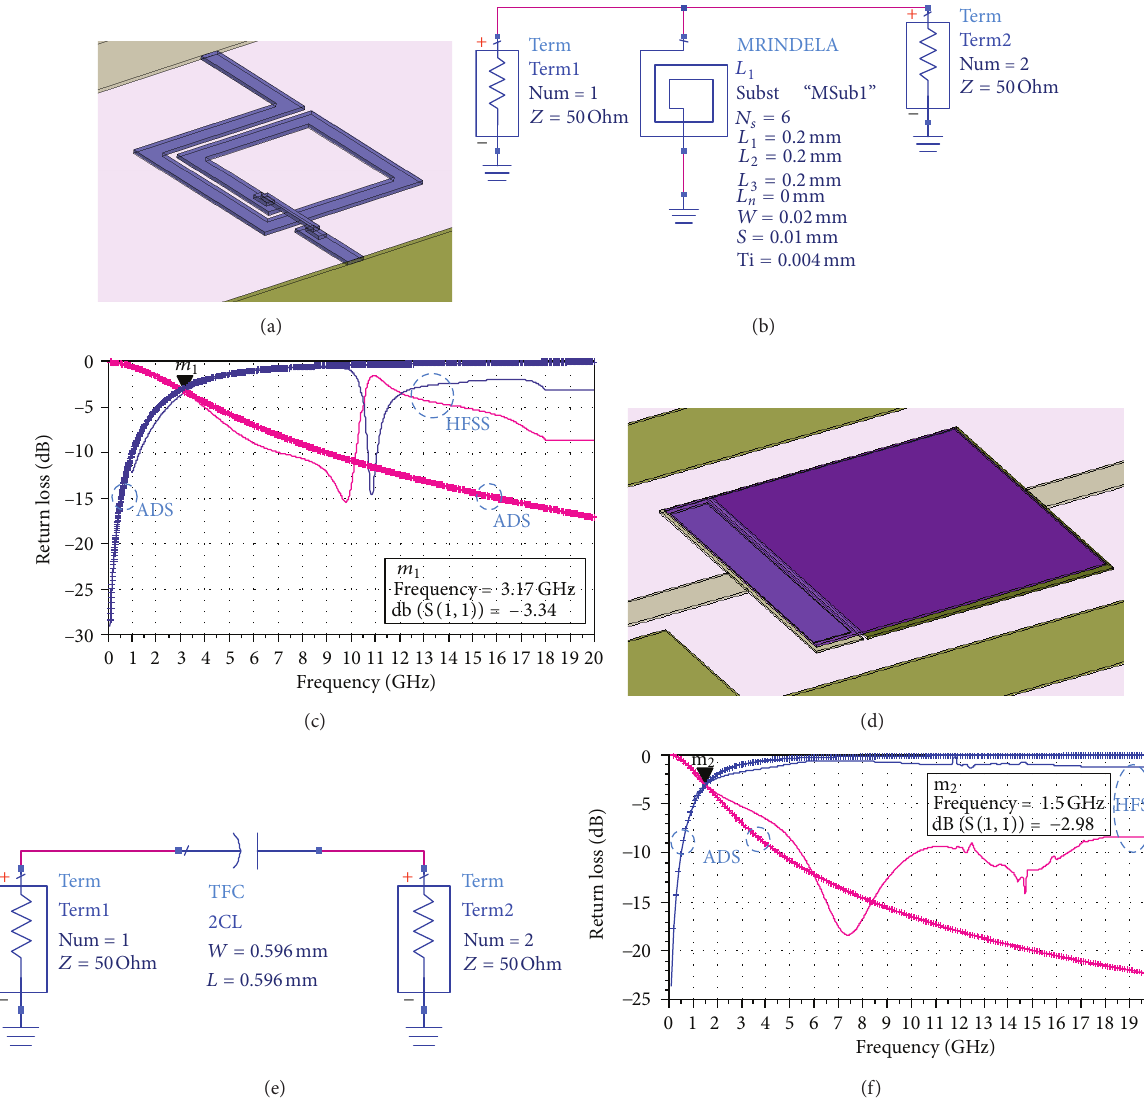
F 3: Performance of each antenna element according to ADS and HFSS: (a) full-wave simulation of the inductor in HFSS; (b) electric circuit model for the inductor in ADS; (c) simulated S circuit model for the capacitor in ADS; (f) simulated S